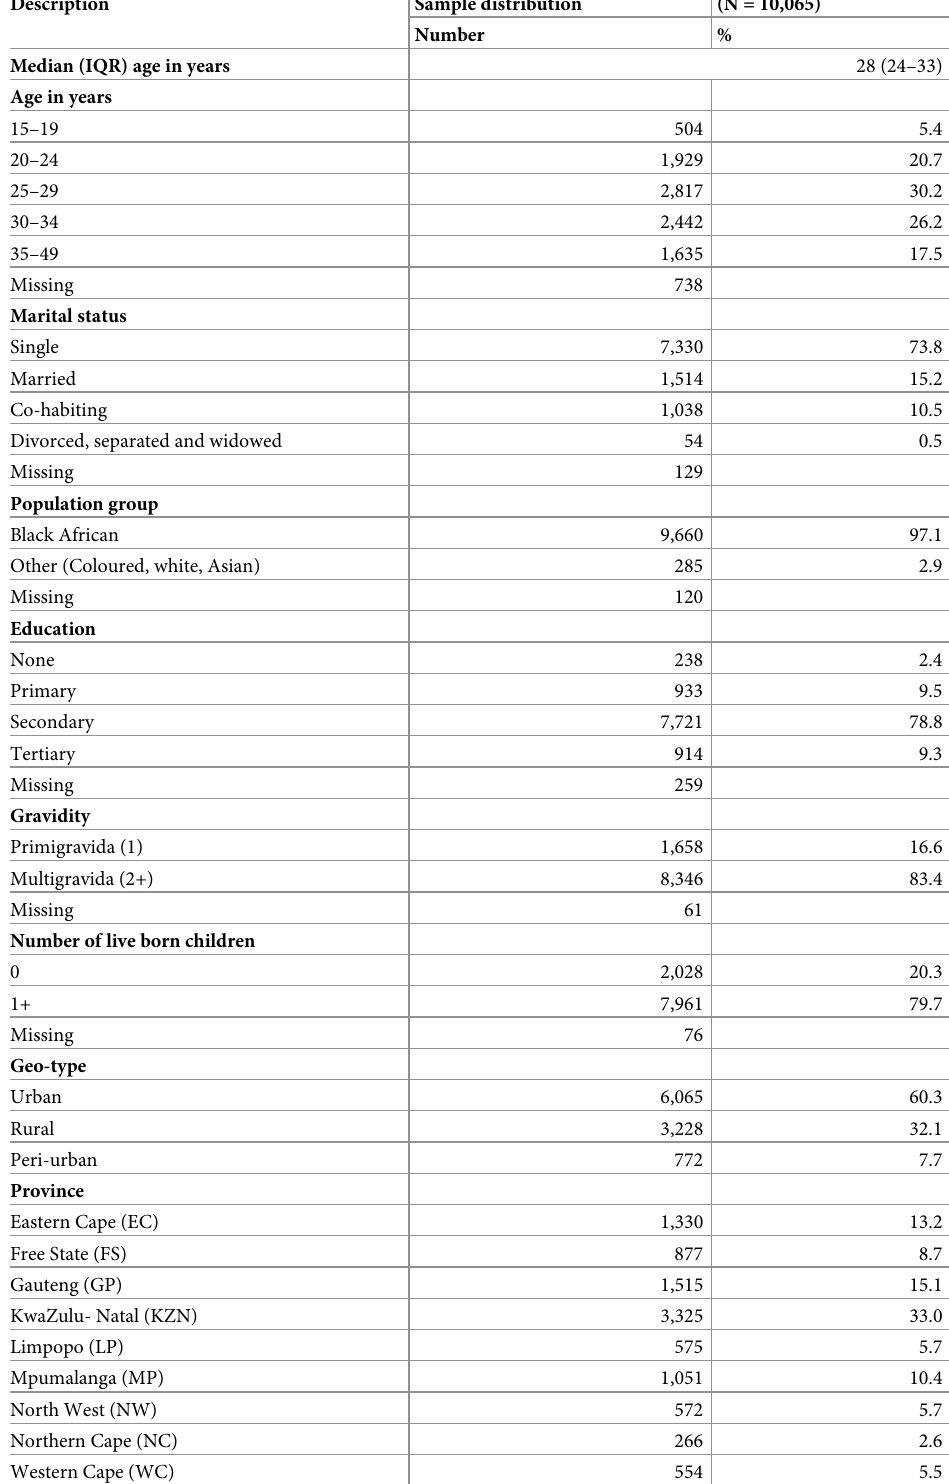
Table 1. Demographic characteristics of HIV-positive participants, in the 2017 antenatal HIV sentinel survey,